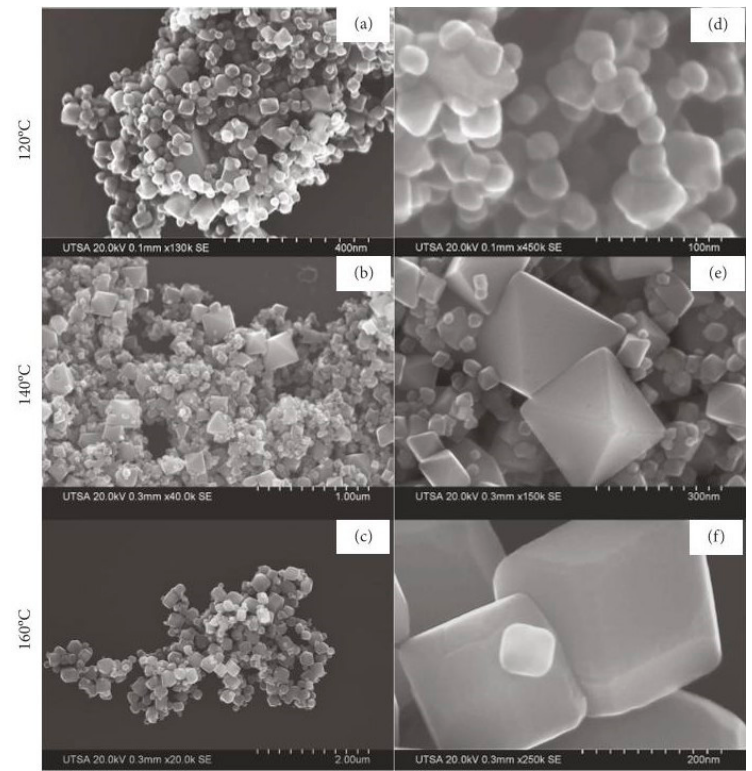
Figure 5. SEM images of magnetite nanoparticles obtained after hydrothermal synthesis at different temperatures: ( a , d ) 120 °C, ( b , e ) 140 °C, and ( c , f ) 160 °C (adapted from [58] with permission from 2019 Nayely Torres-Gómez et al.). temperatures: ( a , d ) 120 ◦ C, ( b , e ) 140 ◦ C, and ( c , f ) 160 ◦ C (adapted from [58] with permission from 2019 Nayely Torres-G ó mez et